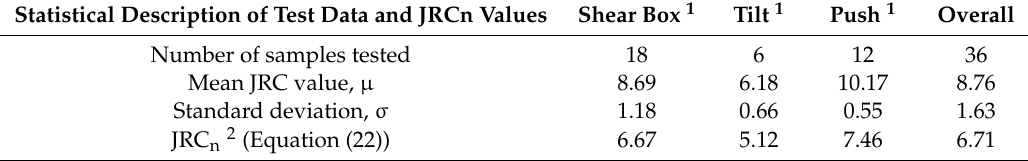
Table 3. JRC values obtained by di ff erent test methods (see Barton and Choubey [4]) and correction for